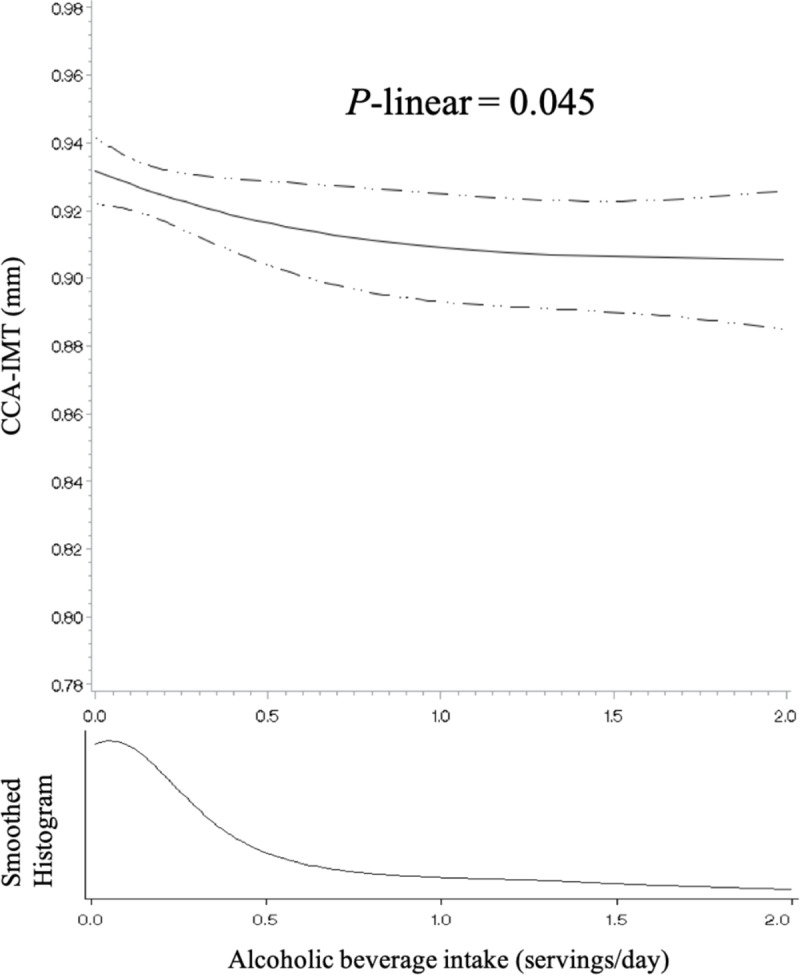
Association between alcoholic beverage intake and common carotid artery intima-media thickness among 1,235 participants of the Study of Women’s Health Across the Nation (United States) using restricted cubic splines, 1996–2013.The solid line represents the predicted least squares means computed using sample mean values for continuous covariates and sample percentages for categorical covariates. The dashed lines represent the 95% confidence limits. Three knots were placed at 5th, 50th, and 95th percentiles of the sample distribution, corresponding to 0, 0.10, and 1.68 servings/d, respectively. One serving of alcoholic beverages was defined as one medium can (355 mL) for beer, one medium glass (148 mL) for wine, and one medium shot (44 mL) for liquor. The model was adjusted for age at the carotid scan, race/ethnicity, education level, financial strain, self-rated overall health, BMI, smoking status, non-occupational physical activity level, menopausal status, use of hormone therapy from baseline to the visit of the carotid scan, the number of missing visits for dietary measurements, total energy intake, Alternate Healthy Eating Index (excluding the alcohol component), coffee intake, elevated blood pressure, elevated fasting glucose, elevated triglycerides, and reduced HDL cholesterol. Extreme alcohol intake (> 2 servings/d) was trimmed from the graph due to sparse data. Abbreviations: CCA, common carotid artery; IMT, intima-media thickness.